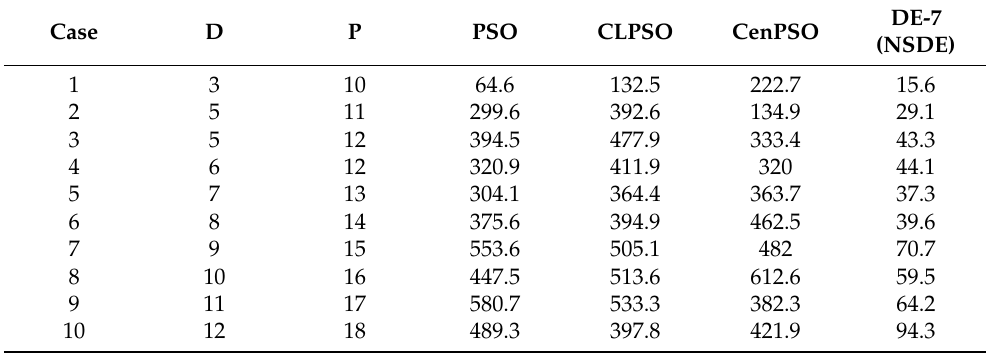
Table 15. Average number of generations for PSO, CLPSO, CenPSO, and DE-7 (NSDE) algorithms with NP = 30; D r = P r =0.1.